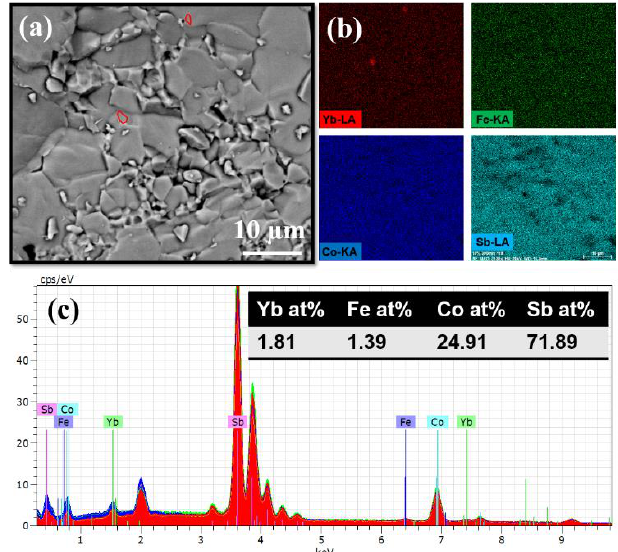
Figure 2. ( a ) SEM image, ( b ) elemental distribution, and ( c ) EDS spectra of n-type Yb 0.25 Fe 0.25 Co 3.75 Sb 12 compound.